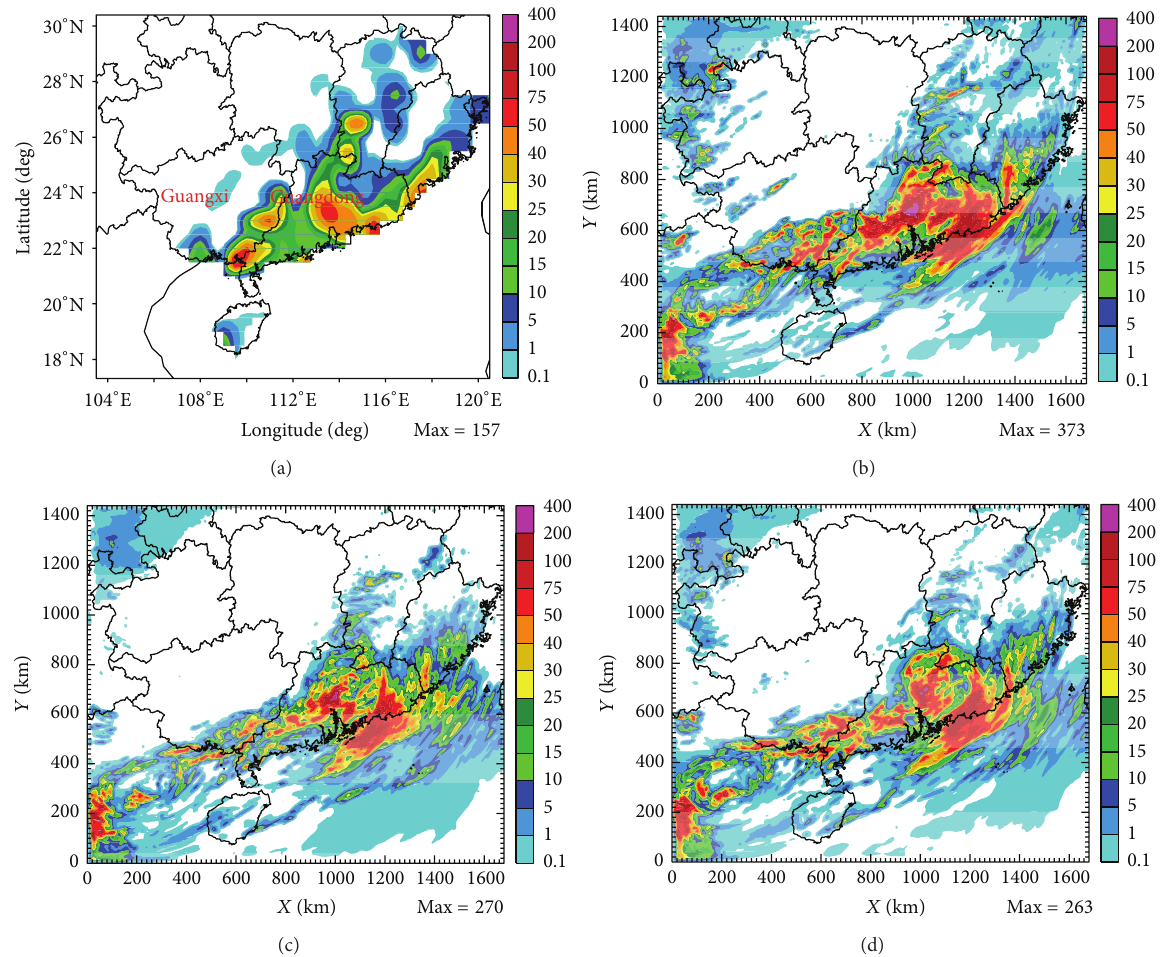
Figure 9: 12h accumulated precipitation from (a) observations, (b) CNTL, (c) RADSND, and (d) ALLDATA between 1200 UTC July 15 and 0000 UTC July 16, 2011 for case